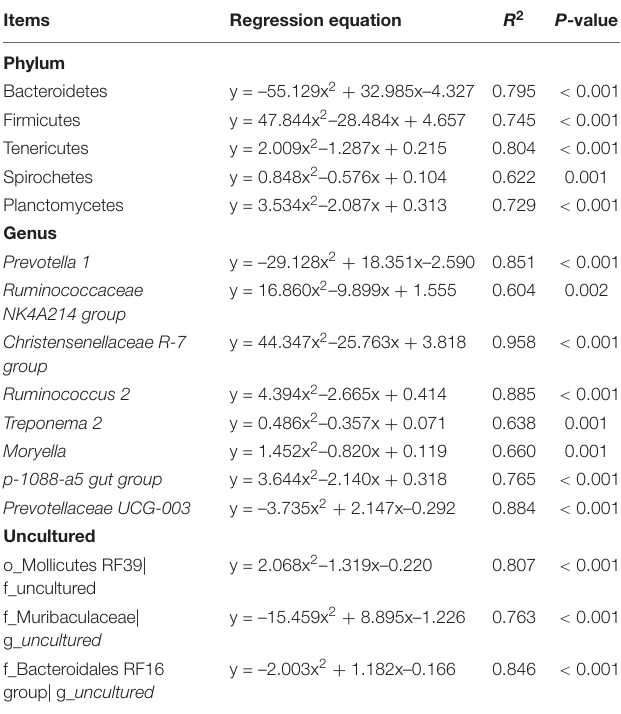
TABLE 7 | Regression relationship between dietary peNDF 1 . 18 level (x) and relative abundance of rumen bacteria (y) ( n = 15, R 2 >